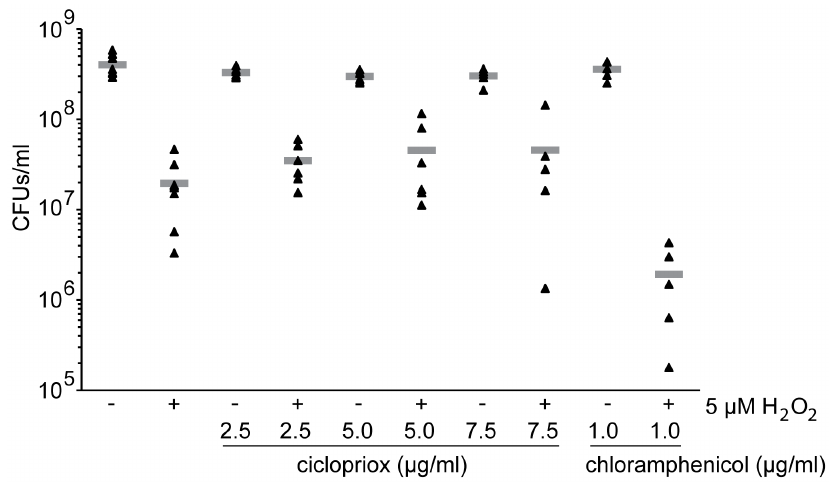
Figure 4. Effects of hydrogen peroxide exposure on bacterial response to ciclopirox. ATCC H 25922 TM E. coli were grown to mid- logarithmic phase (OD 600 =0.4) and then subjected to either water or 5 m M H 2 O 2 for 20 minutes. Colony forming units (CFUs) were measured per 1 ml of E. coli grown with either 0, 2.5, 5.0, or 7.5 m g/ml ciclopirox or 1.0 m g/ml chloramphenicol. Each triangle represents a result from an independent culture and the gray bar shows the average. Statistical significance was measured using Student’s t-test.